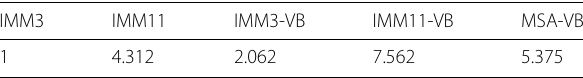
Table 5 Relative computational times for the experiment 2 IMM3 IMM11 IMM3-VB IMM11-VB